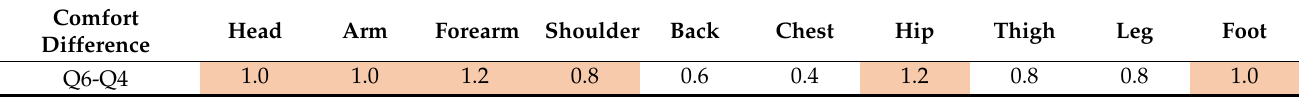
Table 12. Difference between thermal comfort level at Q4 and Q6 for the cold-sensitive group.